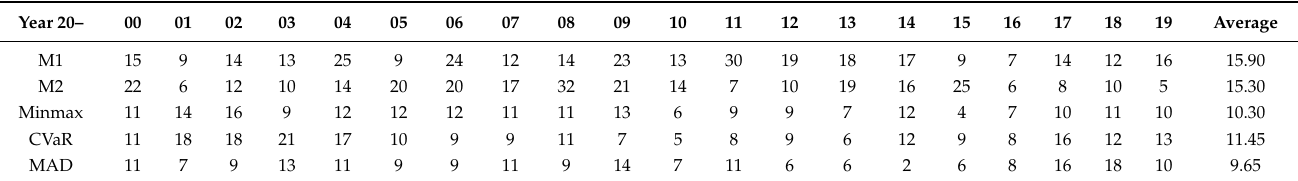
Table 3. Number of stocks in the structure of selected portfolios.